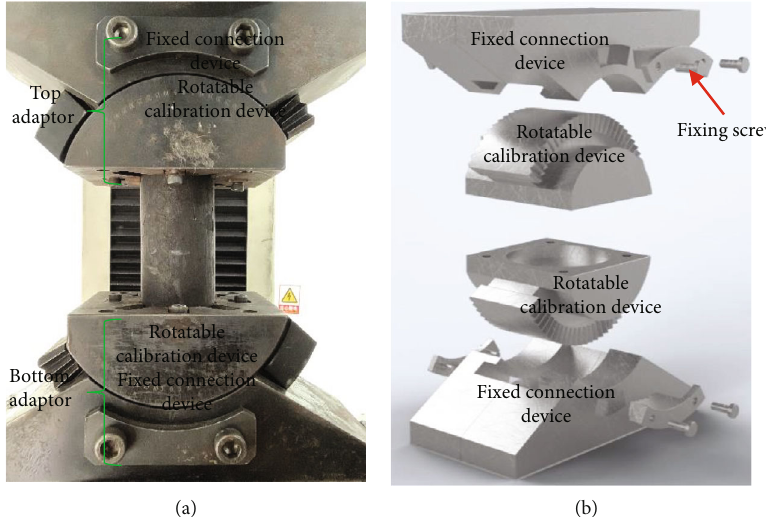
Figure 5: Con fi guration of the IUCS test system: (a) real products ’ picture; (b) schematic diagram [23].